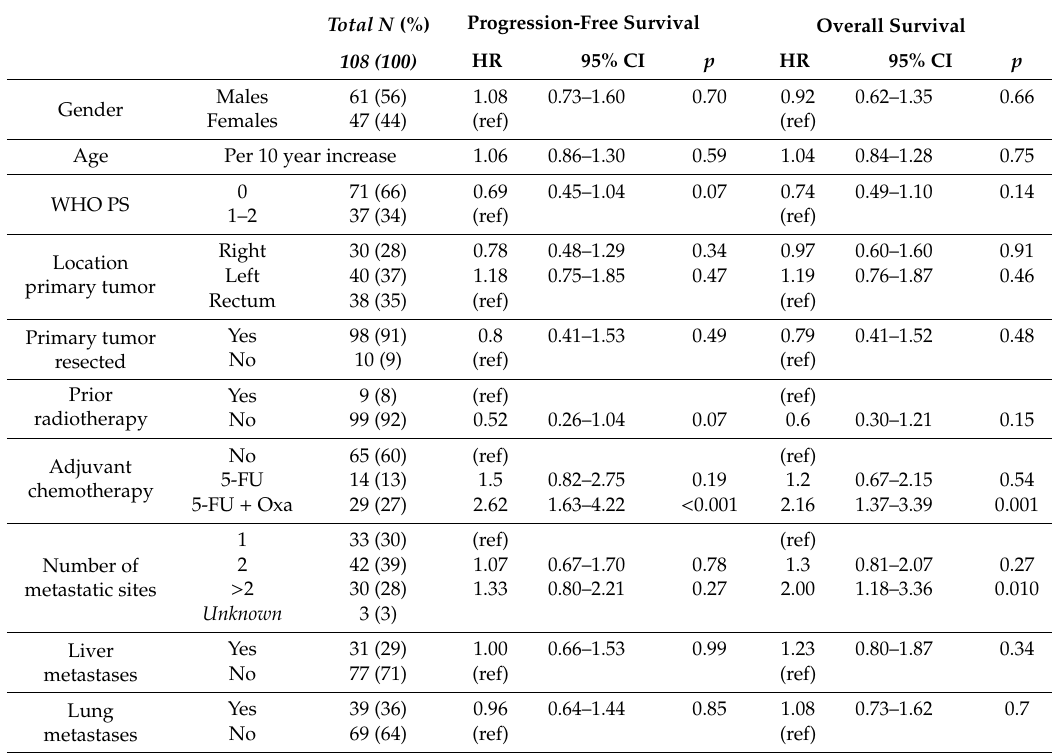
Table 3. Univariate survival analyses of patient